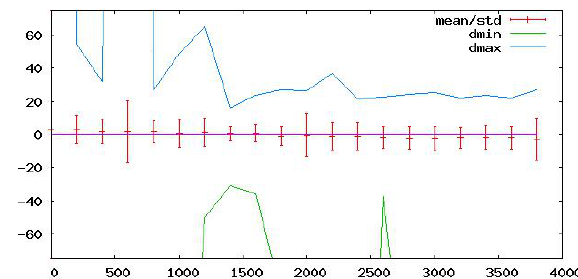
Figure 17: Statistics of whole Terrassa area from north (left) to south (right) for idw